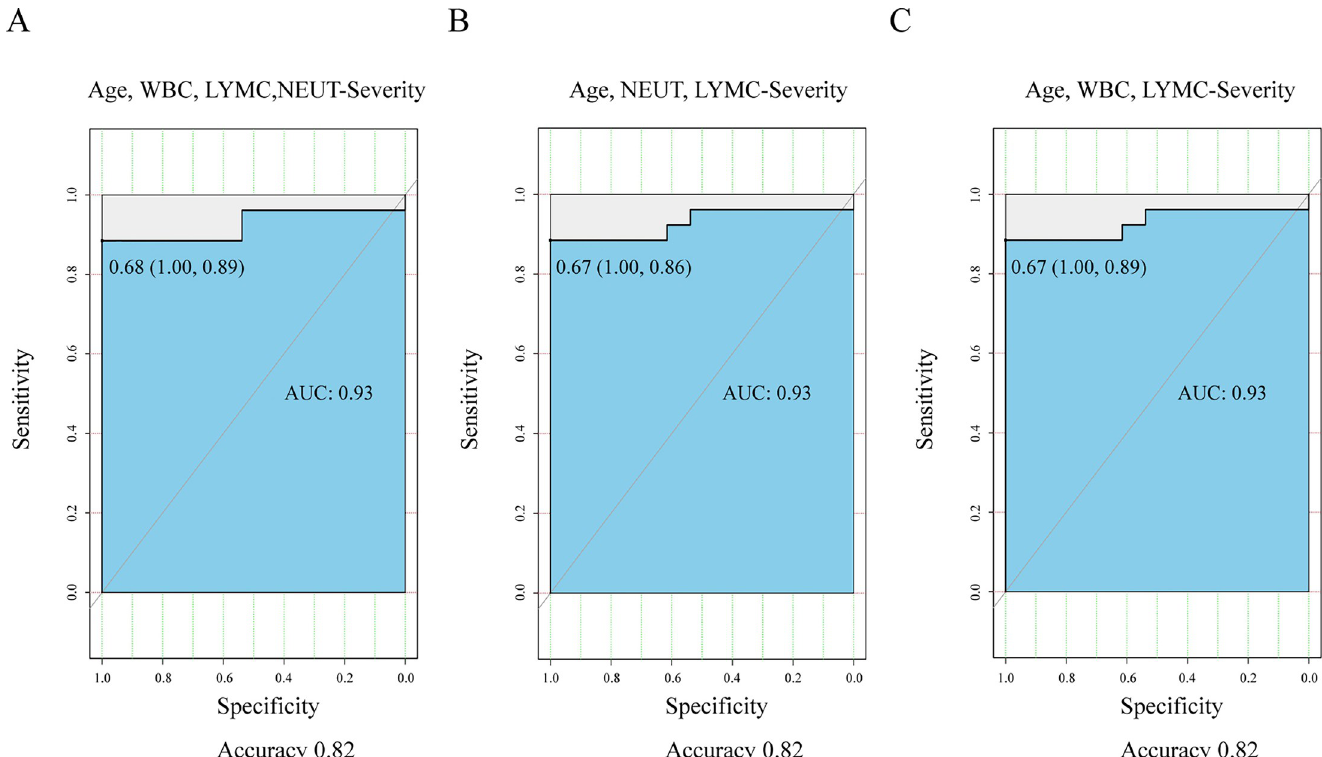
Fig 5. ROC curve used to evaluate the predictive value of the features selected by the MCDM algorithm for the severity of COVID-19. (A). ROC curve used to evaluate the predictive value of {Age, WBC, LYMC, NEUT} for the severity of COVID-19. (B). ROC curve used to evaluate the predictive value of {Age, NEUT, LYMC} for the severity of COVID-19. (C). ROC curve used to evaluate the predictive value of {Age, WBC, LYMC} for the severity of COVID-19. Stratified random sampling: 80% for the “training set” and 20% for the “testing set”.